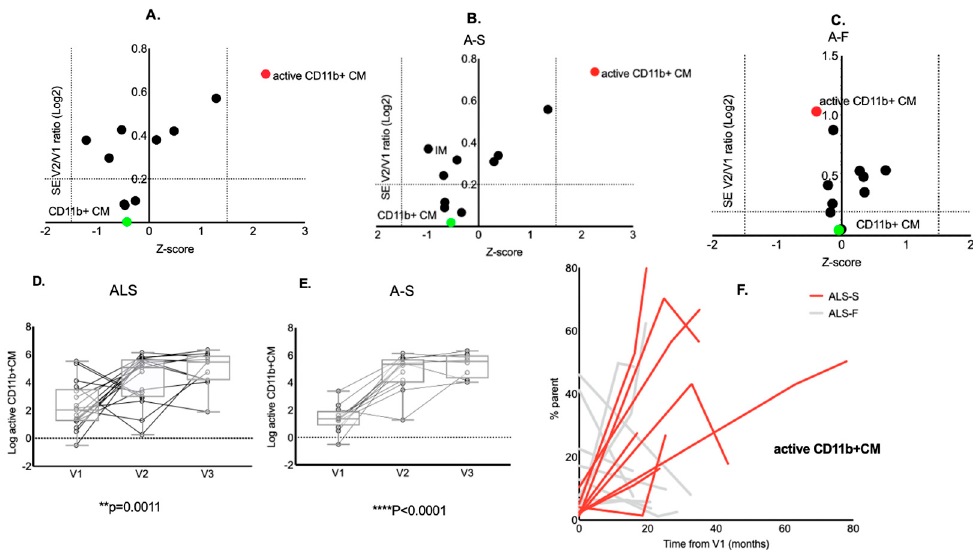
Figure 3. Changes in monocyte subset frequencies between longitudinal time points. Analysis of stability of expression of monocyte subsets between V2 and baseline (V1) in individuals with ALS and in slow progressing ALS (A-S). Active CD11b+ CM (red dots) are the only monocyte subset to increase over time, showing a significant elevation between baseline and V2 in ALS ( A ), in A-S ( B ) but not in A-F ( C ). In contrast, CD11b+ CM appear stable over time (green dot, A – C ). Box plot representation of ANOVA analysis for repeated measures (mixed model with missing values at random) of the changes from V1 to V3 of active CD11b+ CM. In line with the results of the stability analysis, active CD11b+ CM ( F ) present an up-regulation in the later time points compared to baseline, both for ALS ( p = 0.0011) and for A-S ( p < 0.0001) ( D ). Spaghetti plot representing the change over time of active CD11b+ CM between V1 and V3 with a difference in the pattern of expression of A-F compared to A-S ( E ).